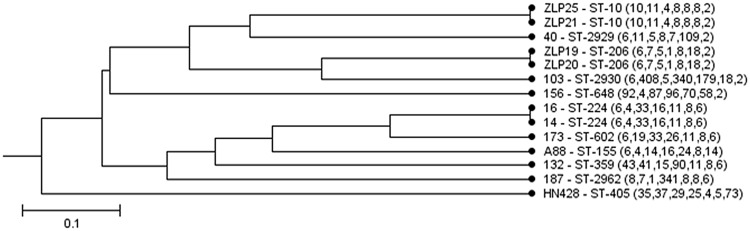
Evolutionary branches of 14 blaCTX-M-14-positive Escherichia Coli.